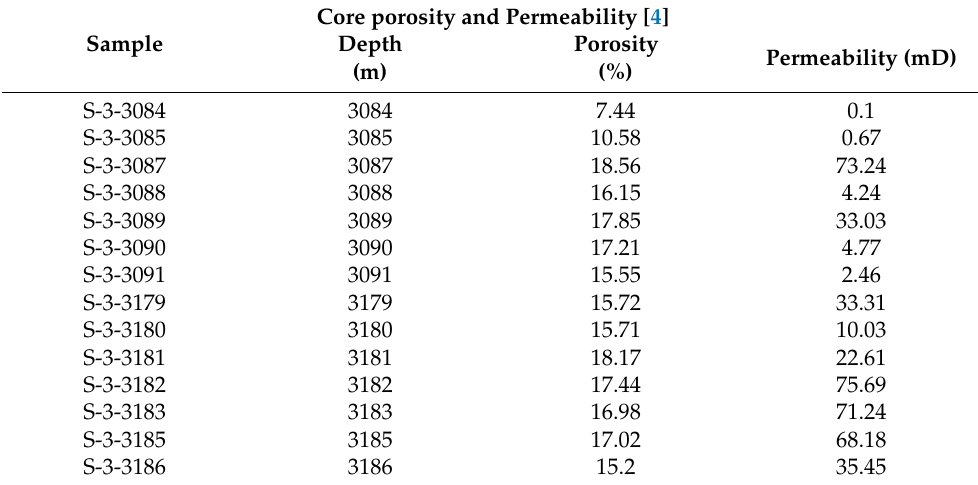
Figure 6. Well log showing shale volume, porosity (Neutron- density log), permeability and water saturation values of various depths from the Srikail-3 well. VSH_GR-shale volume from Gamma ray log; PHIE_ND-Effective porosity from Neutron Density log; PERM_COAT-Permeability after Coate’s method; SW_AR-water saturation following Archie equation. Table 3. Petrophysical properties using well log data from Srikail well-3. Table 4. Core Porosity and permeability data from Srikail